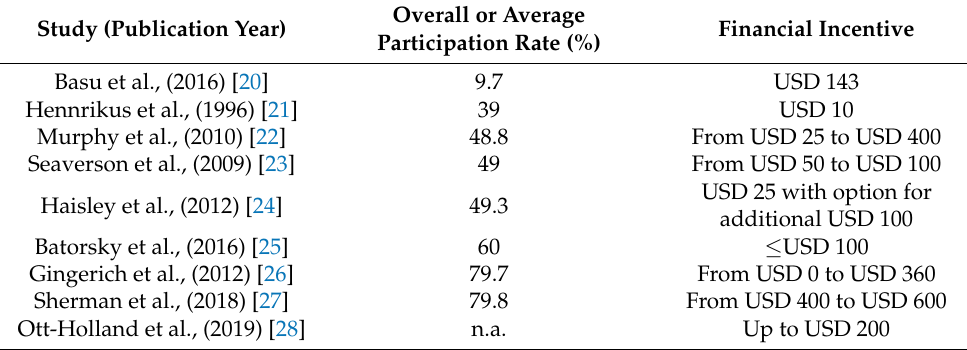
Table 1. Financial incentives and corresponding participation